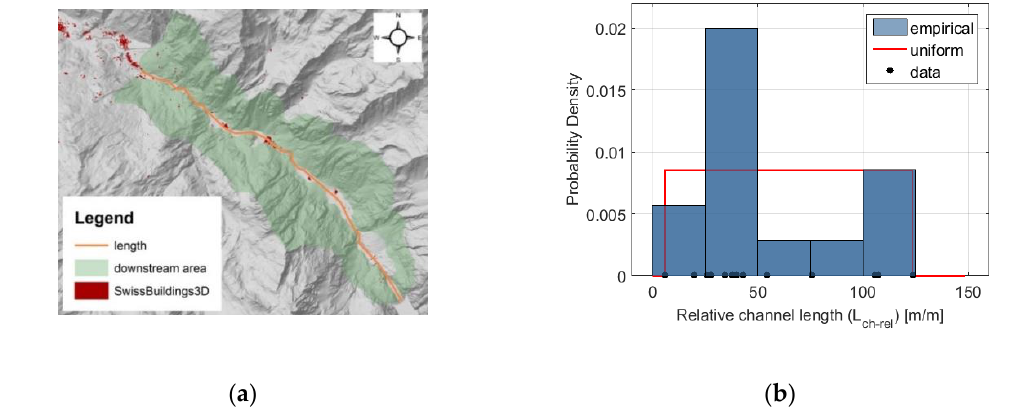
Figure 4. ( a ) Mauvoisin dam downstream area with orange line indicating the flow path; ( b ) empirical data on the relative channel length, L ch − rel , and the probability distribution fitted to the data.